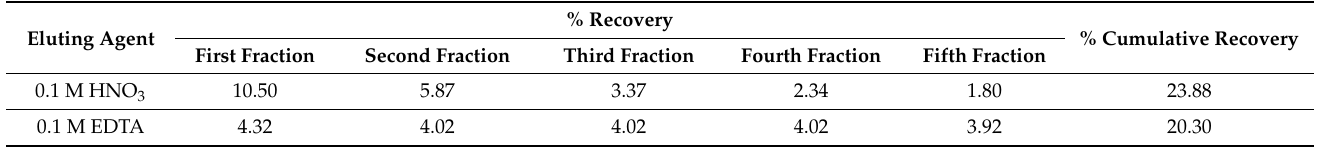
Table 3. Desorption of Cd(II) of